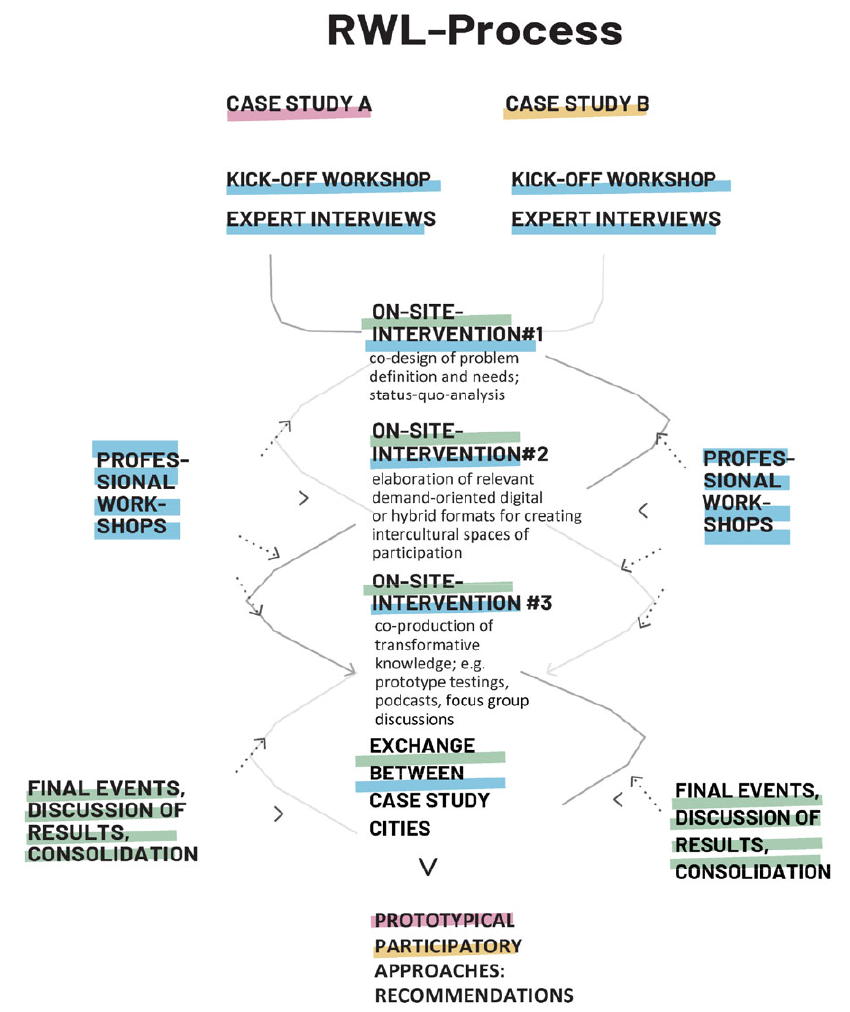
Figure 1. RWL process. Source: INTERPART